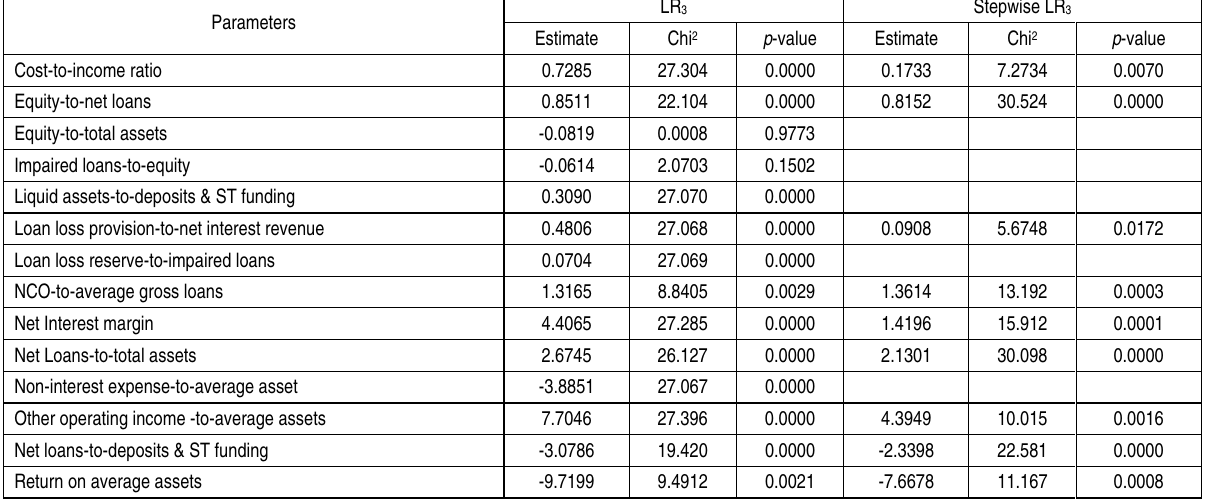
Table 5. Logistic regression analysis result for Model